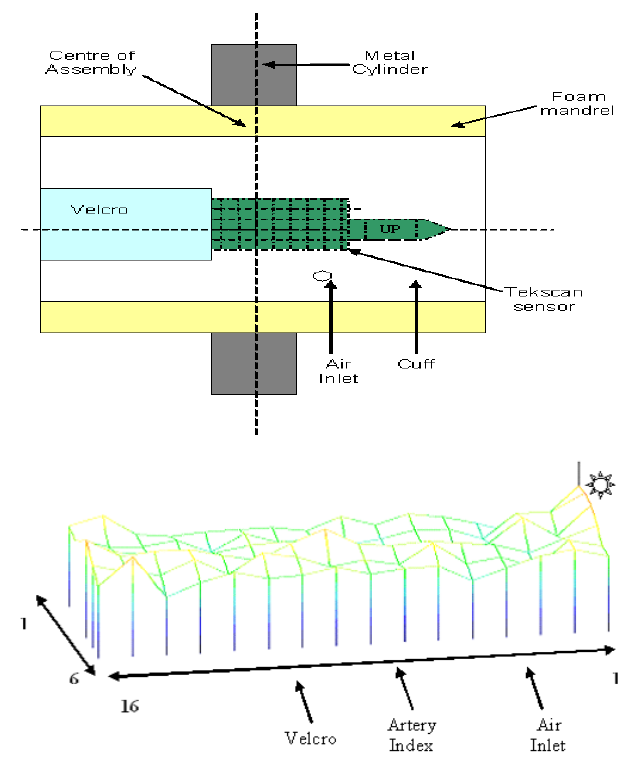
Fig. 3(b) Tekscan sensor arrangement for measurement of pressure at interface of metal cylinder and cuff 1W and cuff